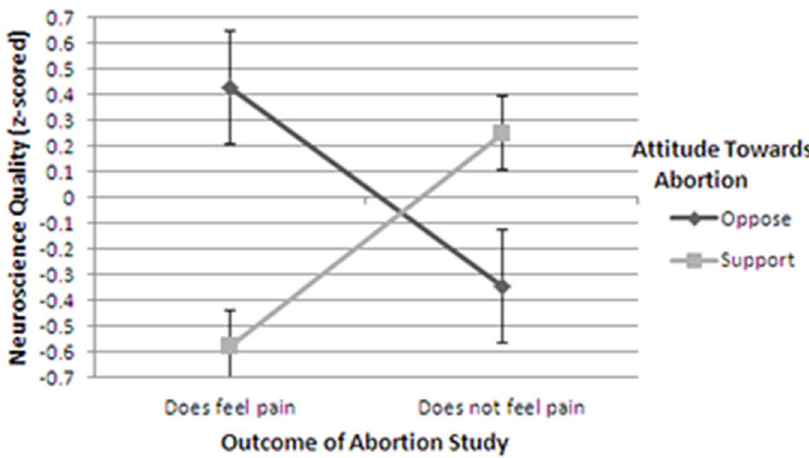
Figure 2. Perceptions of the quality of neuroscience as a function of the outcome of the study and participants’ a priori attitudes towards abortion. Note that error bars are + / 2 1